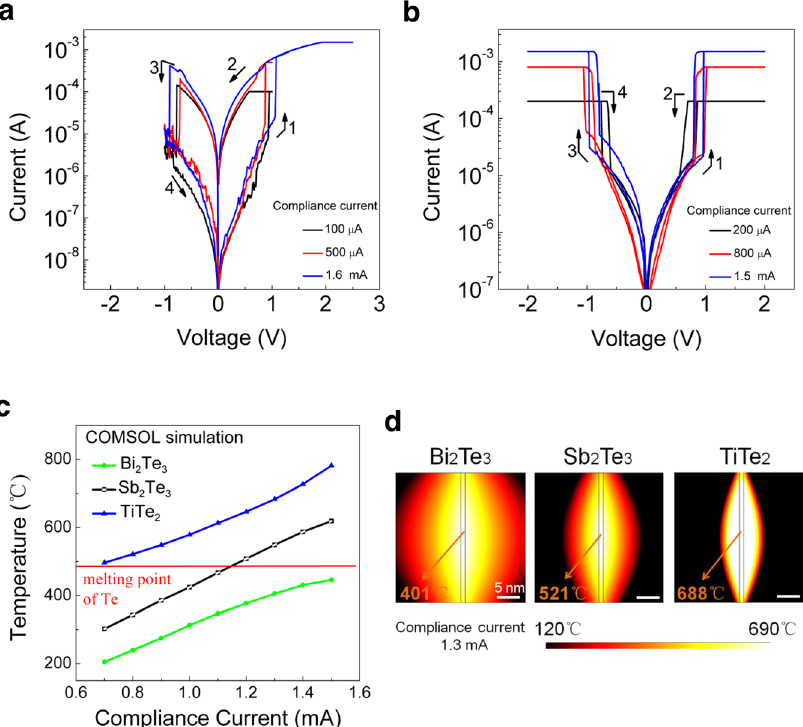
Fig. 6 RS characteristics of the TBT and TT*T control devices, and thermodynamics simulations of the temperature fi elds established during fi lamentary conductions. I – V curves of the Pt protected ( a ) TBT device and ( b ) TT * T device under various CCs. ( c ) Simulated CC-dependent local peak temperature in TBT, TST, and TT * T devices. ( d ) Simulated temperature distributions in these three devices under 1.3-mA